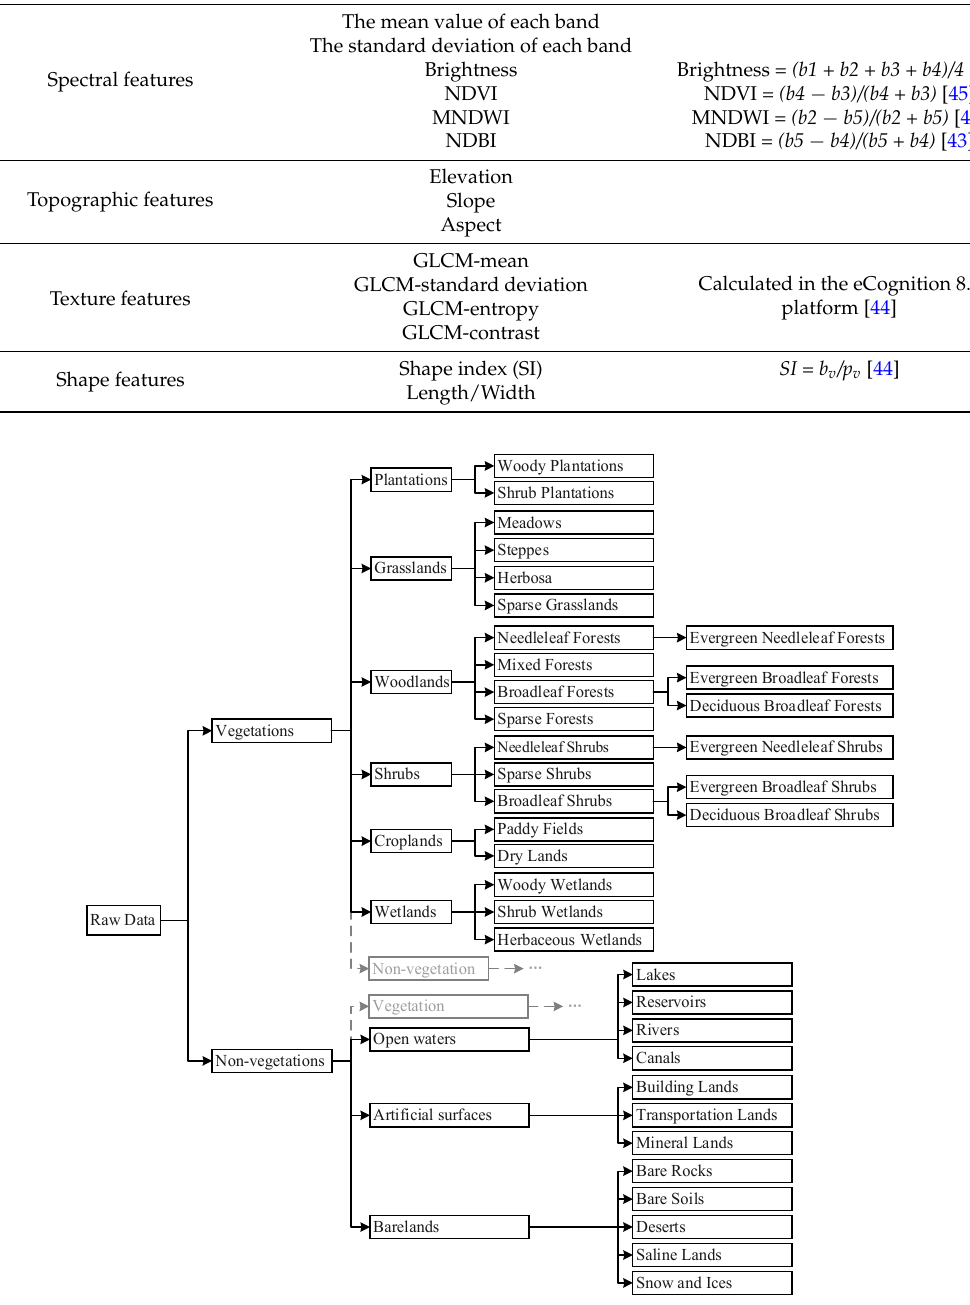
Figure 5. A representative conceptual hierarchical structure of the land cover classes used for generating the CLC-SW2010 product.